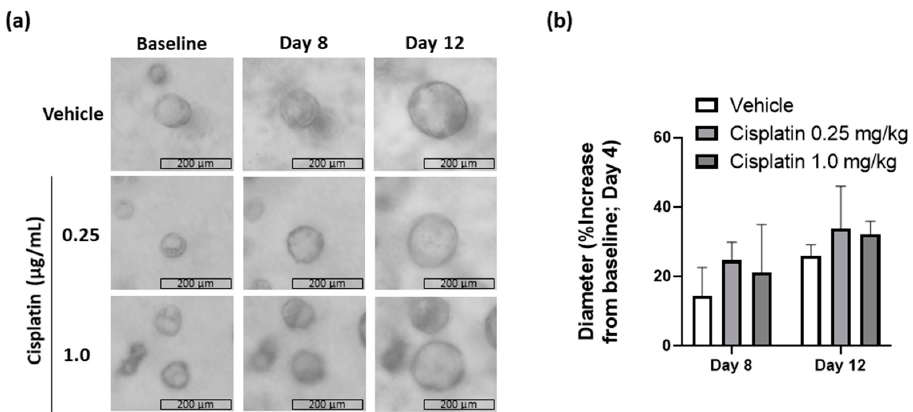
Figure 5. Long-term effects of cisplatin on cyst growth. ( a ) Representative images of individual cysts treated with vehicle or cisplatin at respective doses on Day 4 (baseline) and growth observed on Day 8 and Day 12; ( b ) quantification of cyst diameter from images acquired on Day 8 and Day 12 and normalized to diameter at baseline (Day 4). Graphs showing median values with error bars representing upper quartiles. Scale bar = 200 µm.